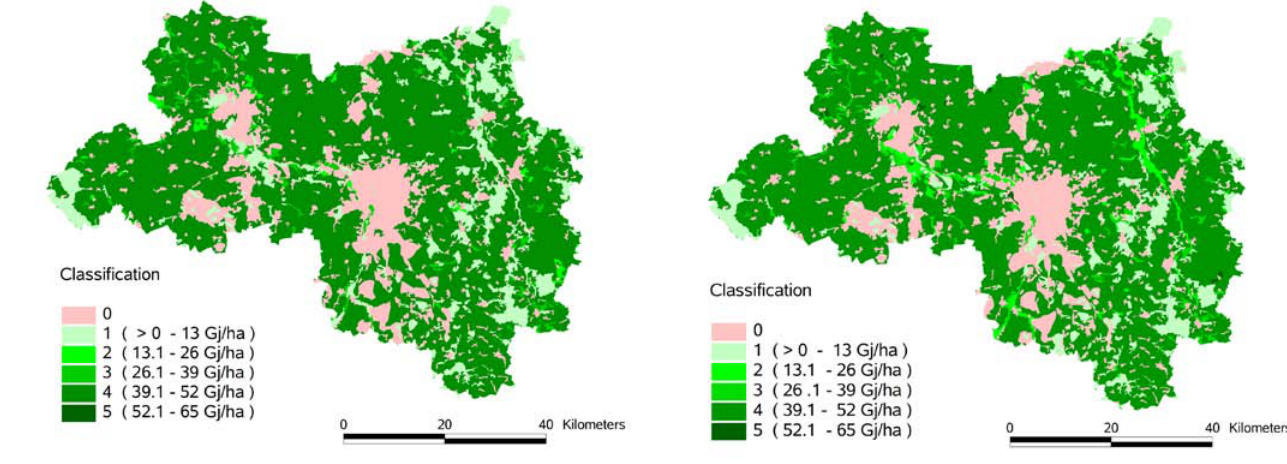
Figure 4: Spatial distribution of the aggregated ecosystem service “food provision” in the year 1990 (left) and 2000 (right) for the region of Leipzig, Halle, and surrounding